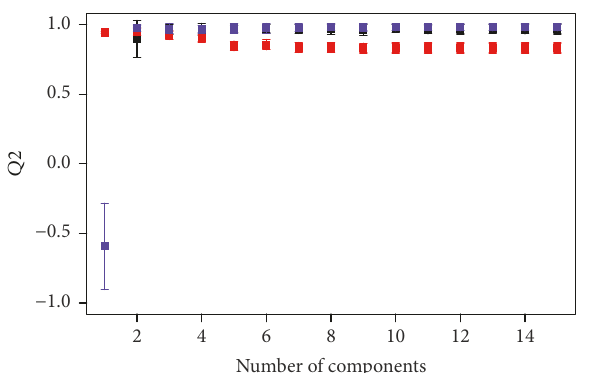
Figure 1: Results of discrimination by species, 7-fold cross-validation. Black represents ATR-mIR, red NIR, and blue 1 H-NMR. The squares show the mean of the 𝑄 2 values averaged over all 7 models; the error bars show the standard deviation of these 𝑄 2 . All techniques produced 100% accurate predictions at the top of the curves (2–4 components).